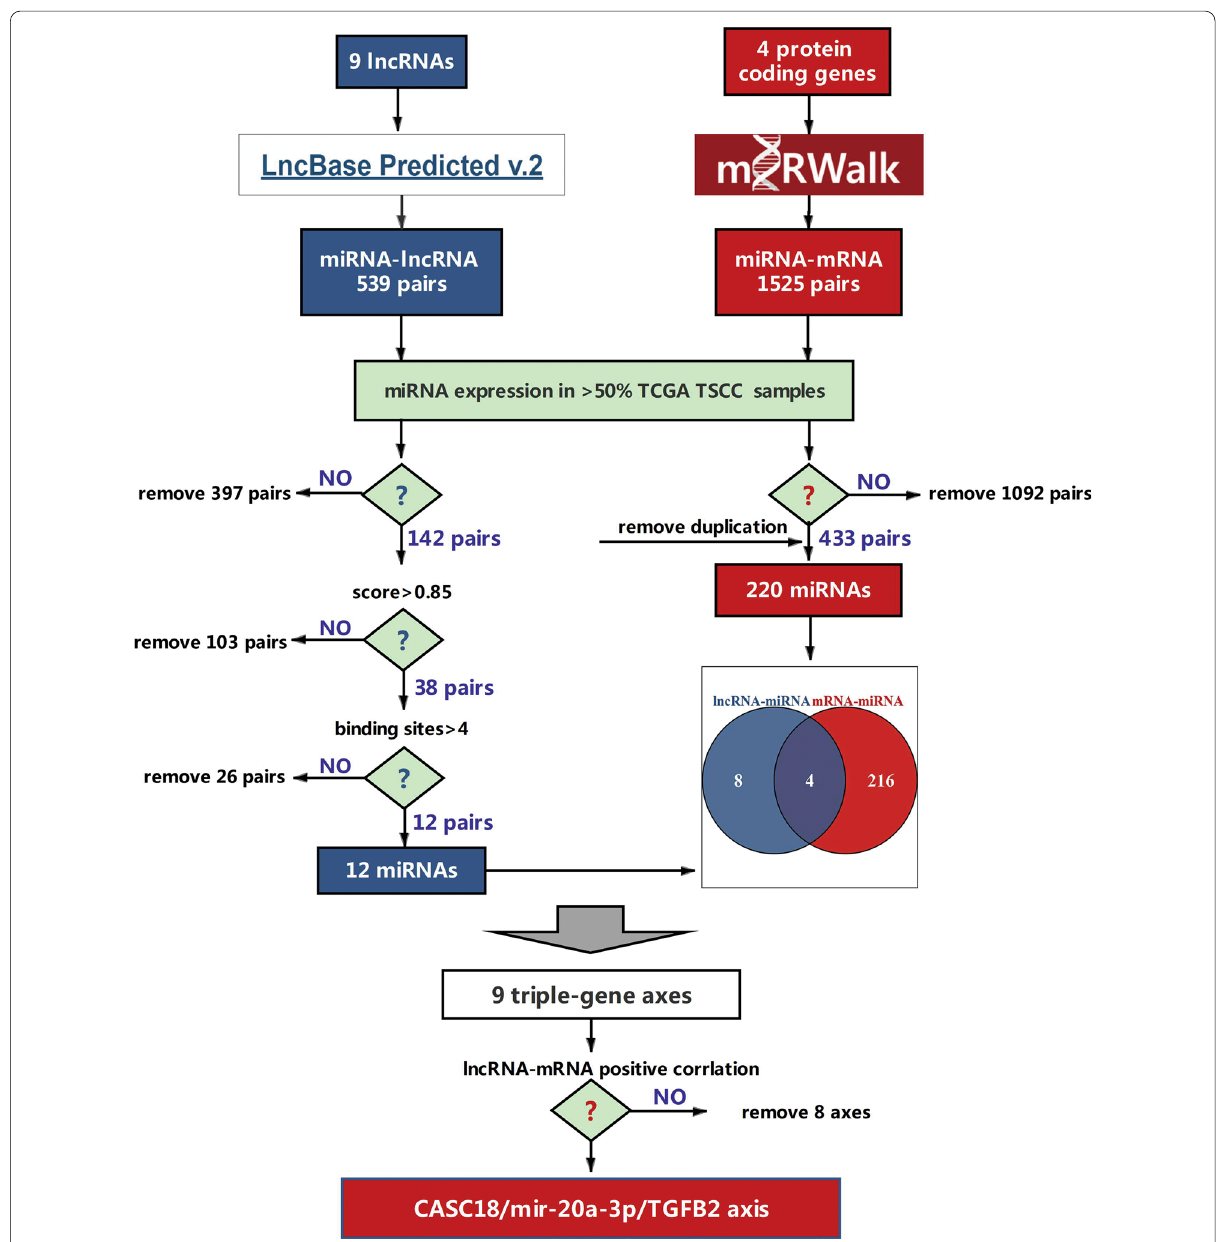
Fig. 3 Flowchart for ceRNA axes